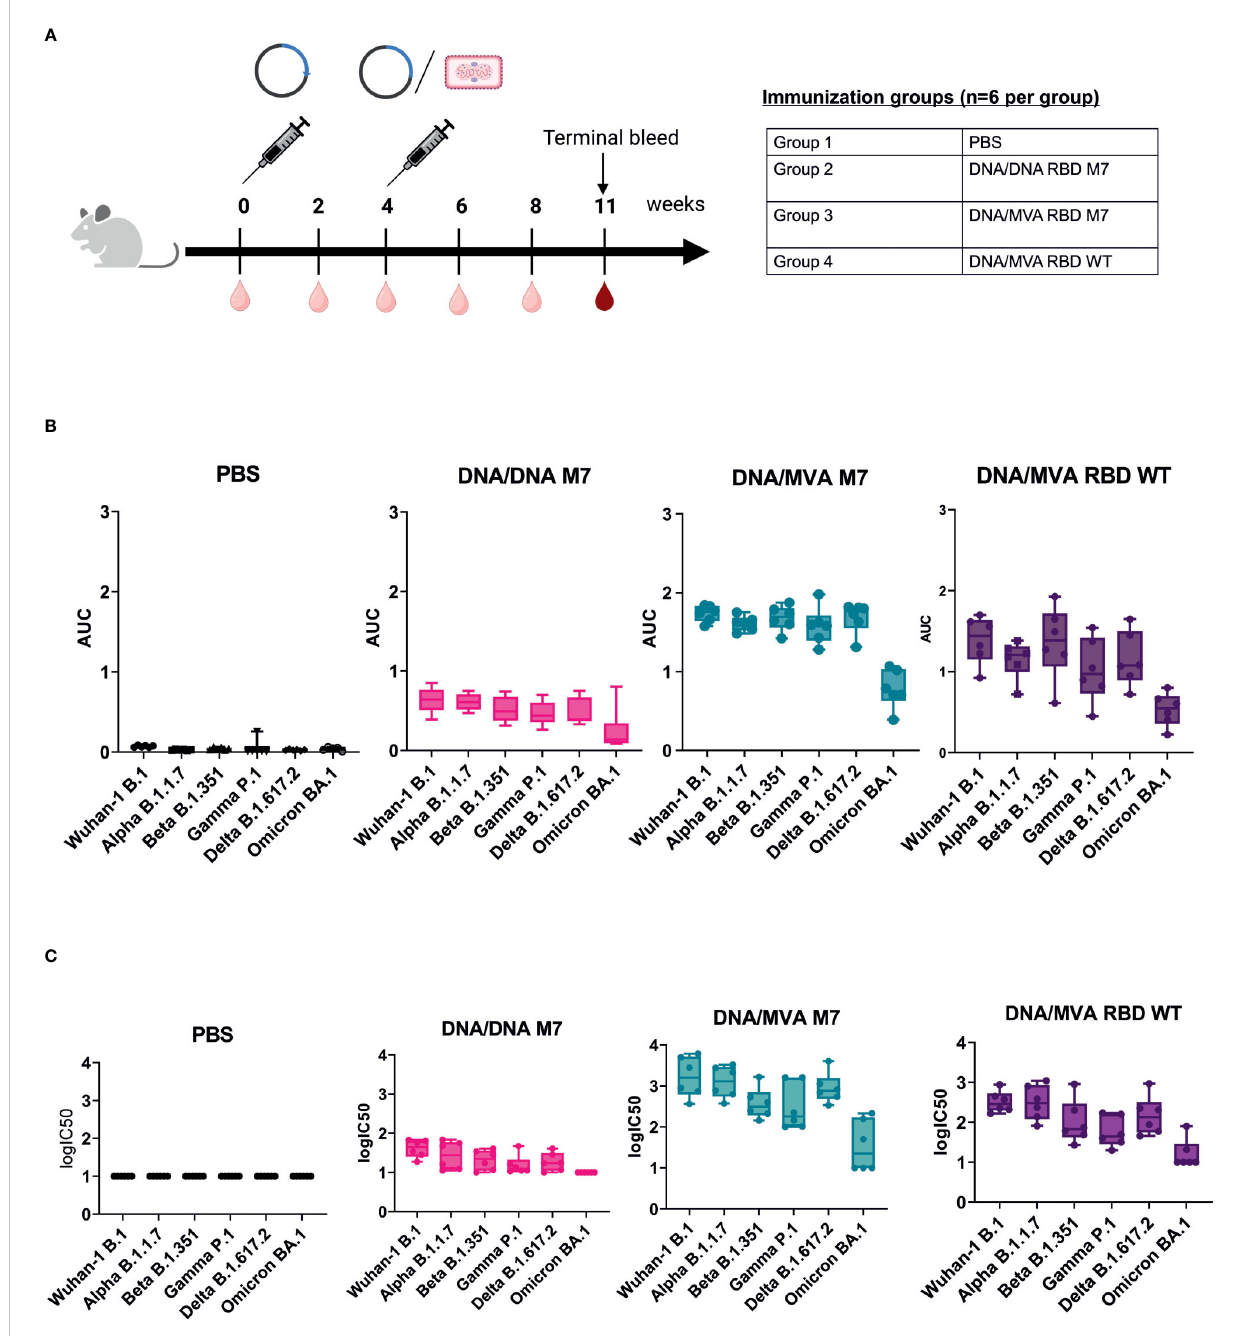
FIGURE 4 DNA/MVA superior to DNA/DNA regimen in induction of binding and neutralising antibodies against VOCs. (A) Immunization schedule of BALB/c mice vaccinated with either DNA/DNA or DNA/MVA regimen. For the DNA immunization, mice (n=6) received 50 µg DNA vaccine subcutaneuosly, whereas for the MVA boost mice were immunized either with SARS CoV-2 RBD WT or SARS CoV-2 RBD M7 MVA at a dose of 2x10 7 pfu. Bleeds were taken at two-week intervals (light red symbol) and the terminal bleed at week 11 (dark red symbol) was analysed. (B) Binding antibody titers against VOCs represented as AUC values measured in mice sera from week 11. (C) Neutralization titers shown as logIC50 against VOCs in mice sera collected at week